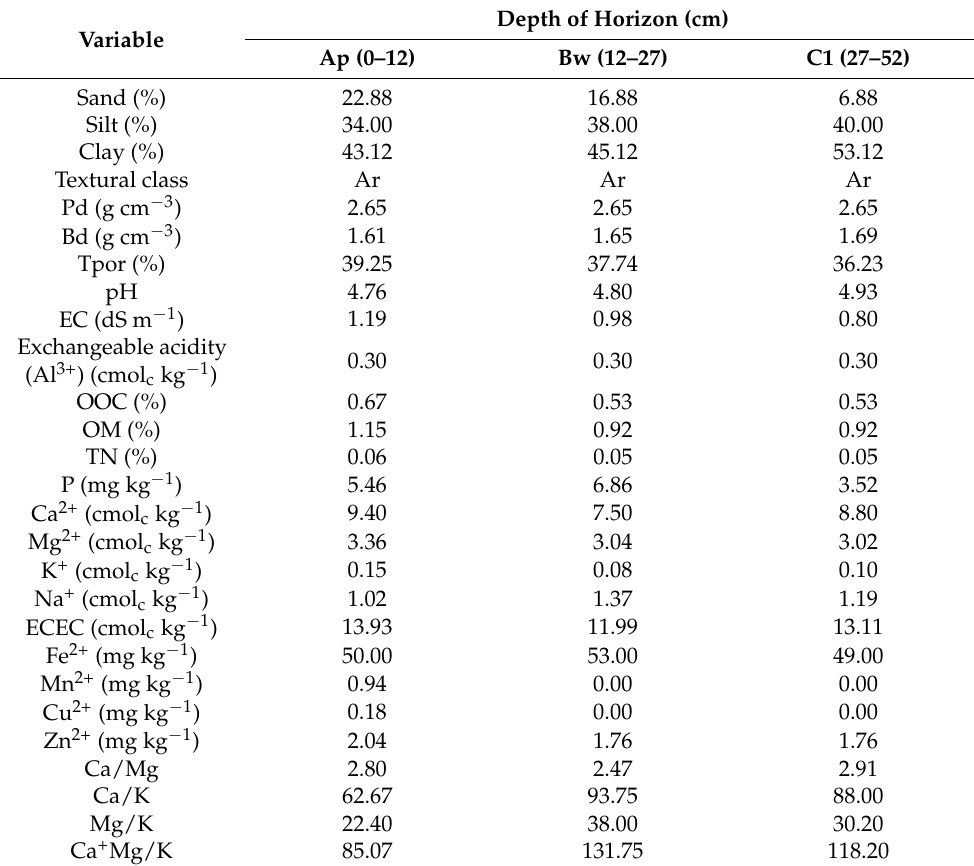
Table 1. Physical and chemical properties of the soil in the experimental area before orchard estab- lishment. Data provided by Universidad Pedag ó gica y Tecnol ó gica de Colombia (UPTC).